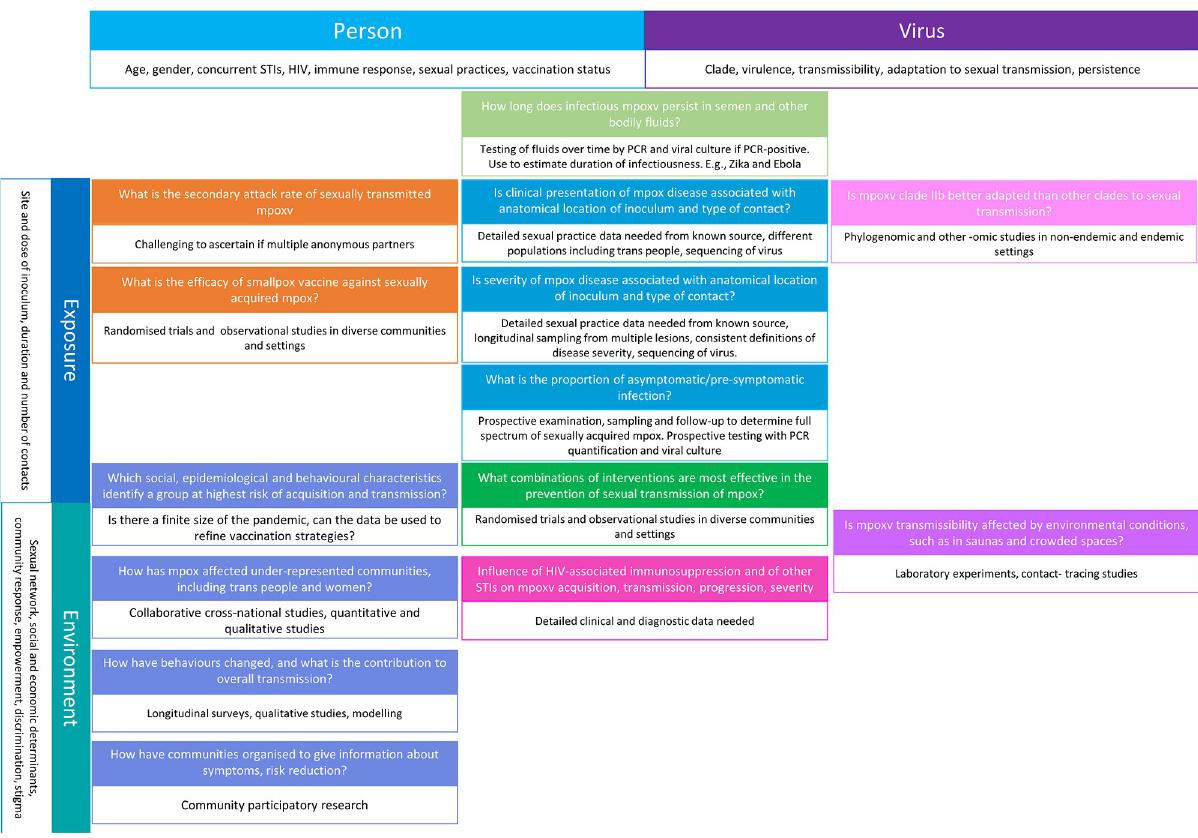
Fig 1. Research questions and factors that could influence the transmission of mpoxv through sexual contact, alone or in combination. The framework includes 4 domains of factors that could affect transmission at the top (the person and the virus) and left-hand side (the exposure and the environment) of the figure, with specific factors listed in the box below the domain heading. Research questions are inside the grid. They may affect or be affected by multiple factors, shown by their position in the framework. S1 Table lists the research questions. mpoxv, mpox virus; PCR, polymerase chain reaction; STI, sexually transmitted